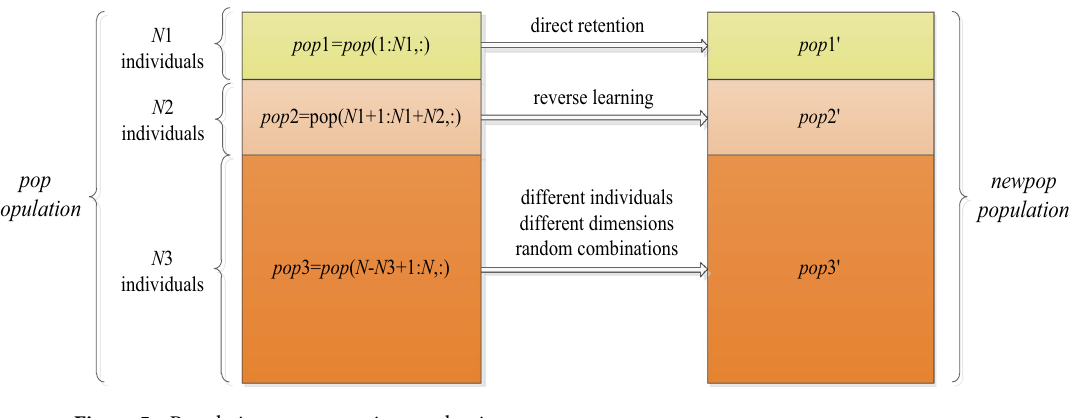
Figure 5. Population reconstruction